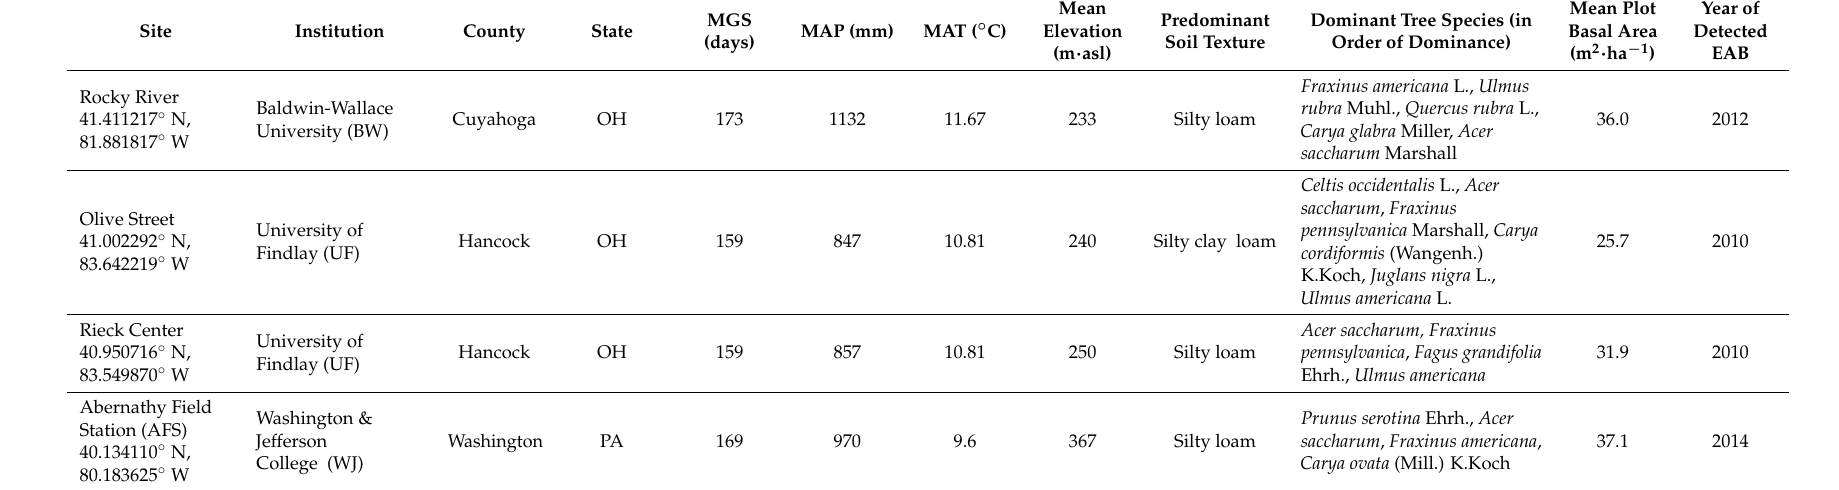
Table 1. Physical characteristics, dominant vegetation, and year of detected emerald ash borer (EAB) infestation by site. Mean growing season, annual precipitation, temperature, elevation, and predominant soil texture were determined following standard Permanent Forest Plot Project (PFPP) methods [34]. MGS: mean growing season length; MAP: mean annual precipitation; MAT: mean annual